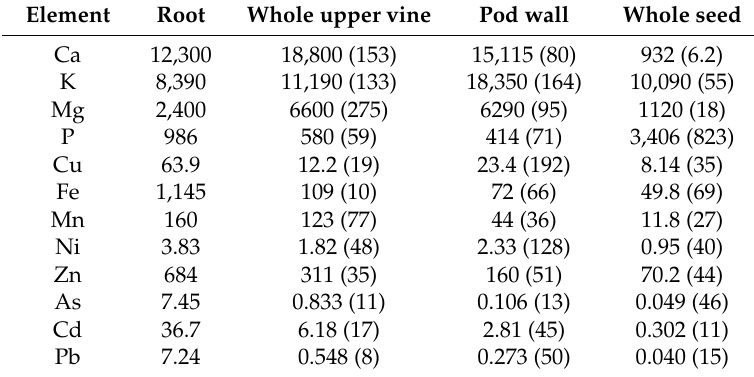
All values within horizontal lines differ significantly at p ≤ 0.05 ( n = 2–4) from preceding ones. Adapted from primary data of Gramss and Voigt [18].